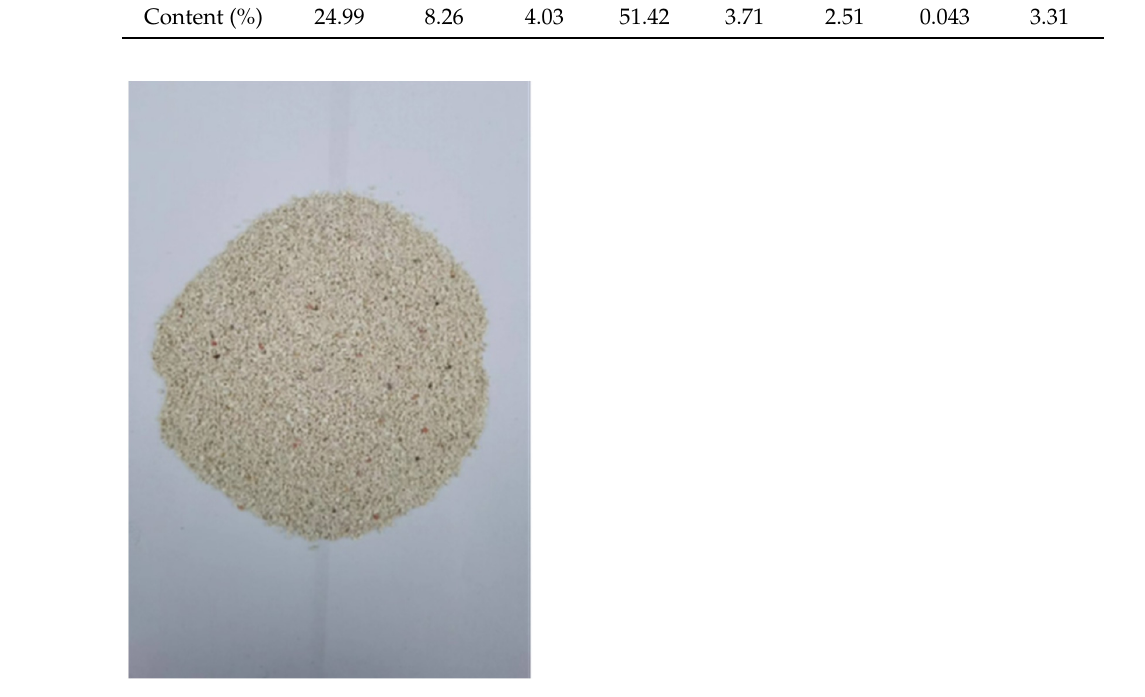
Figure 1. Fine aggregate.